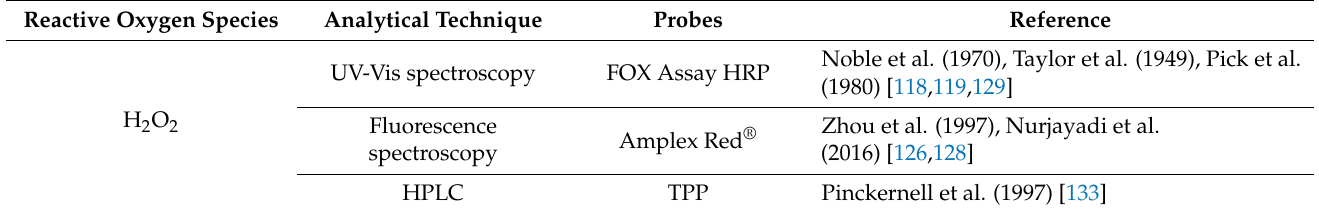
Table 3. Analytical techniques/assays to detect hydrogen peroxide with the corresponding probes and relevant references. Reactive Oxygen